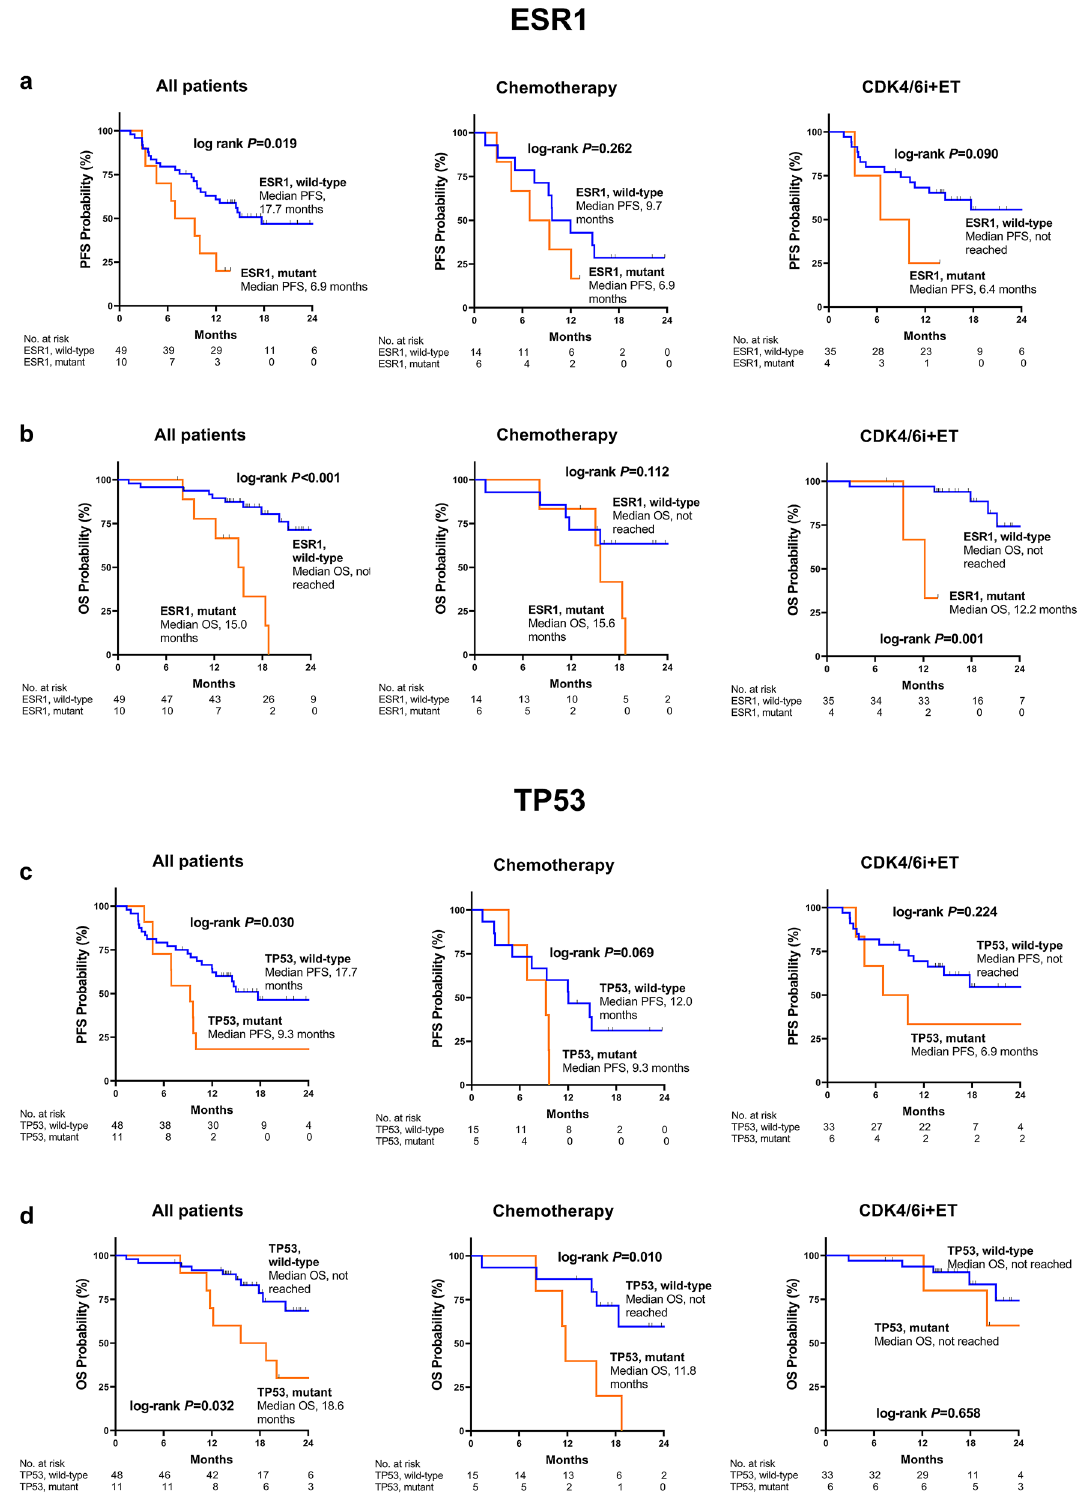
Figure 3. Kaplan–Meier estimates of survival according to ( a , b ) mutant ESR1 and ( c , d ) mutant TP53. P-values were obtained by Log-Rank-Mantel-Cox-tests. PFS, progression-free survival; OS, overall survival; CDK4/6i+ET, cyclin-dependent kinase 4/6 inhibitors in combination with endocrine